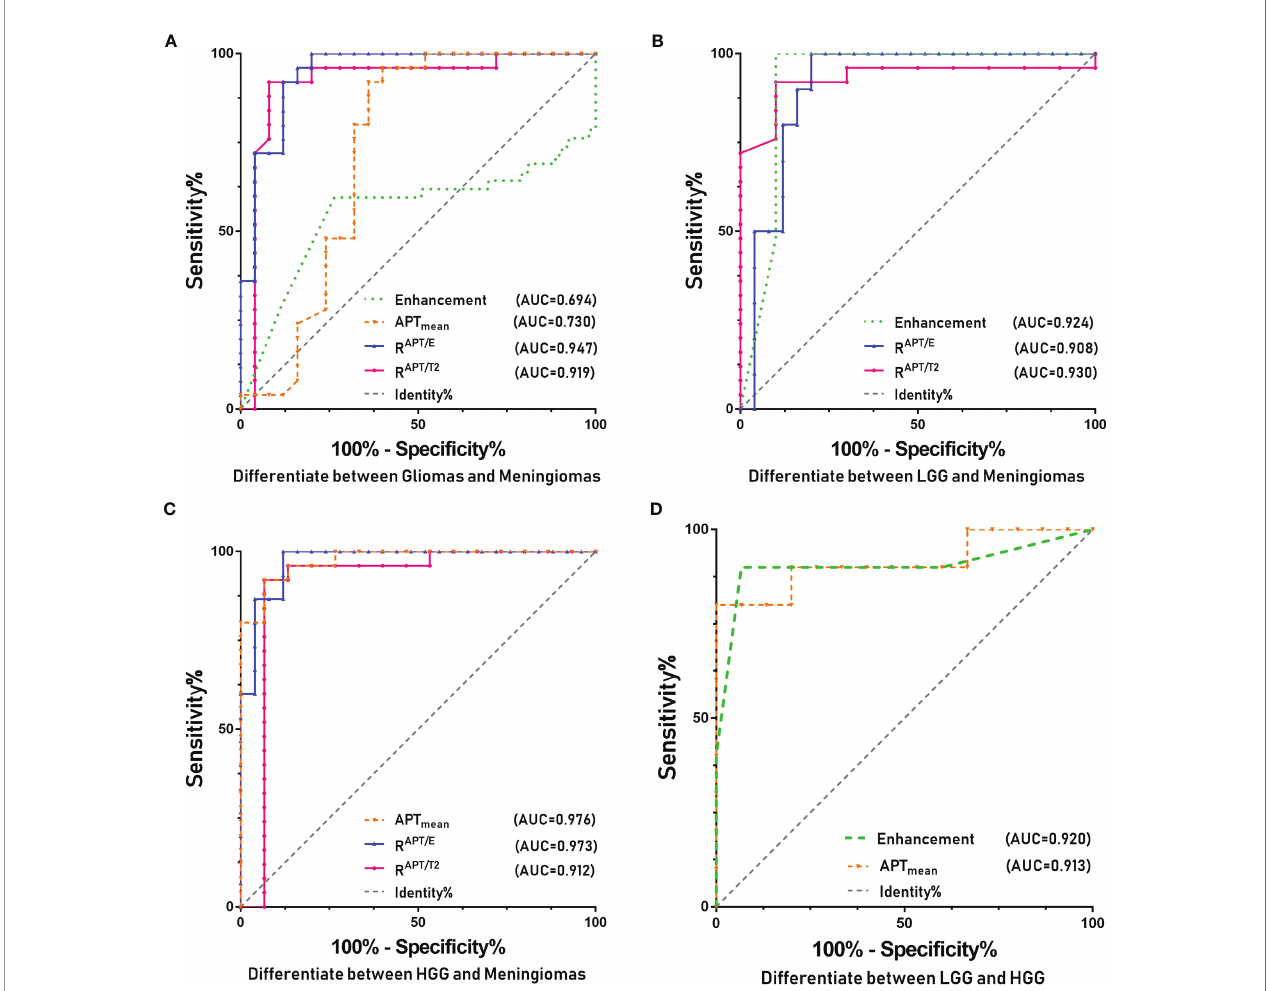
FIGURE 1 | ROC curves of the various parameters of APT and for identifying different types of tumors. (A) Glioma and meningioma. (B) LGG and meningioma. (C) HGG and meningioma. (D) LGG and